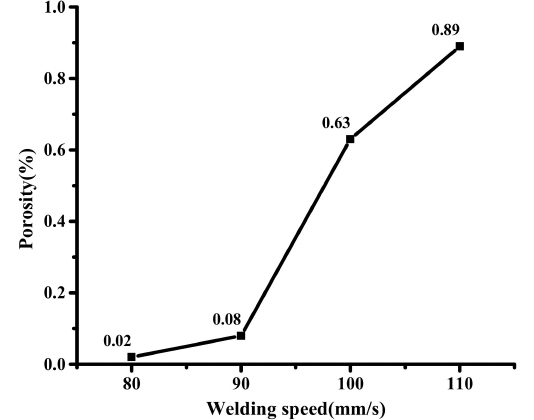
Figure 15. The porosity variation curve of the sealing layer at di ff erent welding